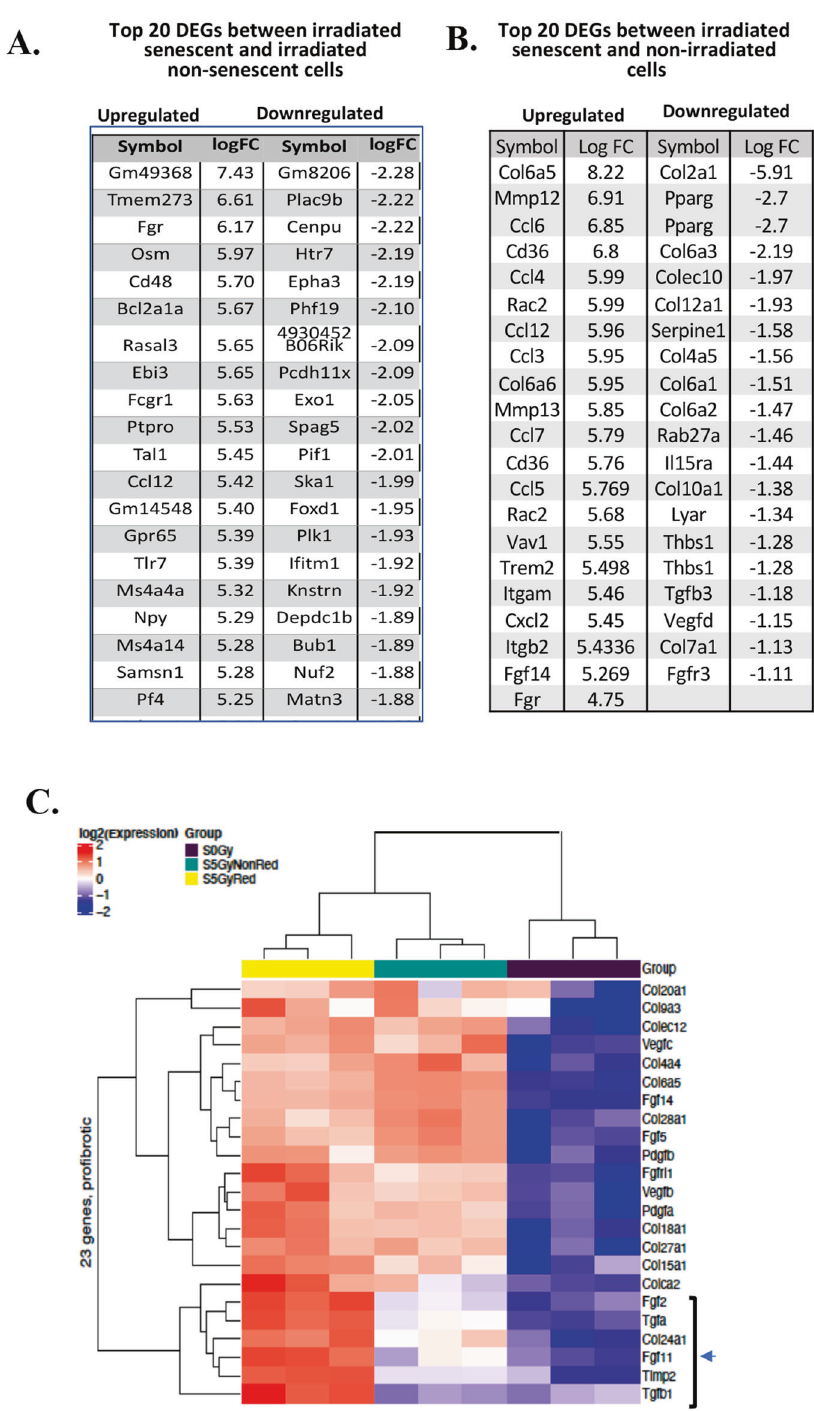
Fig. 3 Prominent transcripts in senescent tdTOMp16 + cells include those, which are associated with fi brosis. A The top 20 up- and downregulated genes in irradiated senescent & irradiated non-senescent samples. B Top 20 up- and downregulated genes in irradiated senescent relative to non-irradiated non-senescent samples. C The heat map illustrates the expression level of the differentially expressed pro fi brotic genes between the three groups. Each row represents a gene and of the nine columns, from left to right, the fi rst three (yellow bar) are irradiated senescent (tdTOM + ) samples, the next three columns (green bar) in the middle are irradiated non-senescent (tdTOM-) samples, and the three columns on the right (black bar) are non-irradiated samples. The value is the z -score of normalized gene expression counts. For any given gene, the red color represents gene expression that is greater than the overall mean, and the blue color represents gene expression that is less than the overall mean. Hierarchical clustering of genes and samples is represented by the dendrograms on the left and across the bottom of the heat